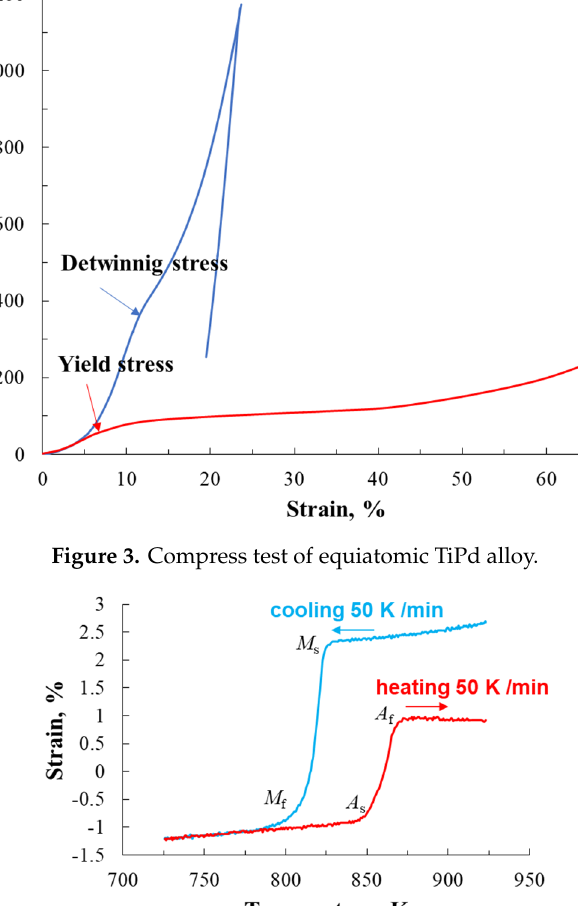
Figure 3. Compress test of equiatomic TiPd alloy.